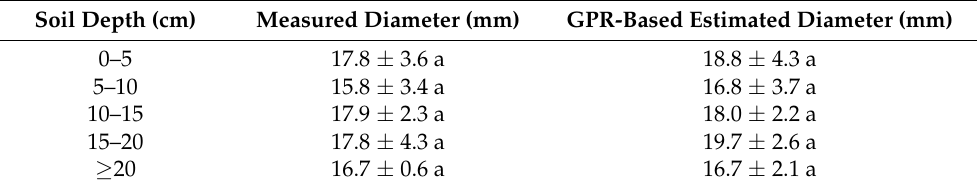
Figure 9. Ground-penetrating radar (GPR) detection frequency of rhizomes in ( a ) each rhizome diameter class and ( b ) each rhizome depth class, where n represents the number of rhizomes in each class identified via excavation. Table 3. Mean rhizome diameter at different soil depths, based on both direct measurement and ground-penetrating radar (GPR) estimation